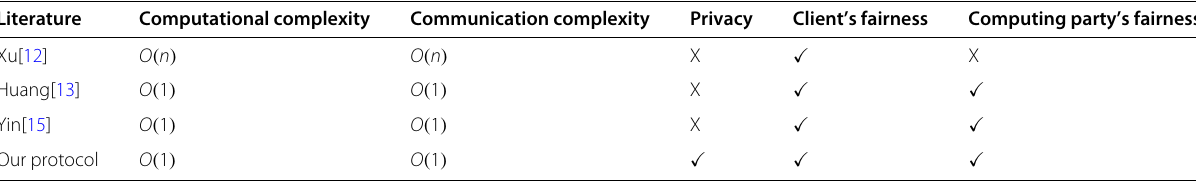
Table 5 The comparison of protocol Literature Computational